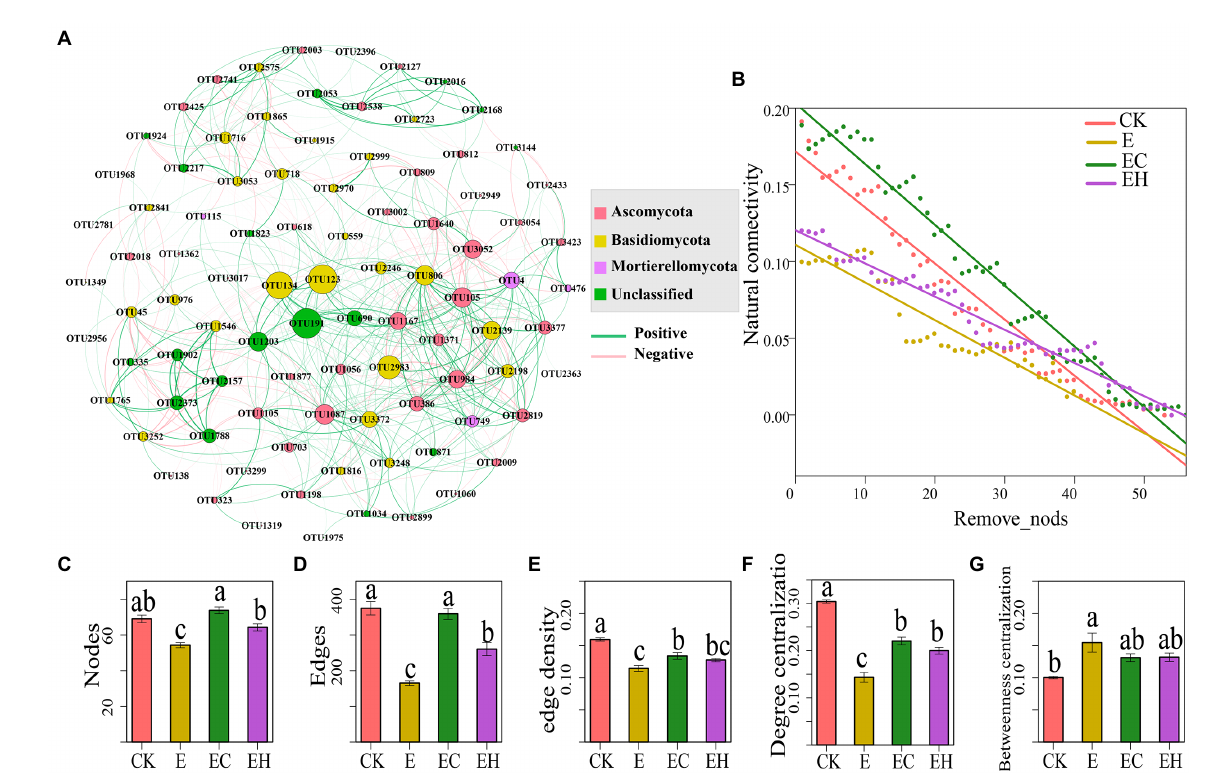
FIGURE 5 Co-occurrence network and topological characteristics of soil fungal communities in pure eucalypt plantations (CK, E) and mixed plantations (EC, EH). (A) Soil fungal co-occurrence network. The Green and pink lines represent positive and negative correlations between OTUs, respectively, (B) Natural connectivity of soil microbial networks in relation to the number of removal nodes, (C) Nodes: node number, (D) Edges: edge number, (E) Edge density, (F) Degree centralization, (G) Betweenness centralization Complexity. CK, the first rotation of E. urophylla plantations; E, the third rotation of E. urograndis plantations; EC, mixed plantations of E. urograndis and Cinnamomum camphora ; EH, E. urograndis and Castanopsis hystrix . Different lowercase letters above the bar chart in different colors indicate significant differences at the 0.05 level. The error bars are the standard errors of the mean values of the network topology parameters. The network topological characteristics of each sample were extracted in subgraph